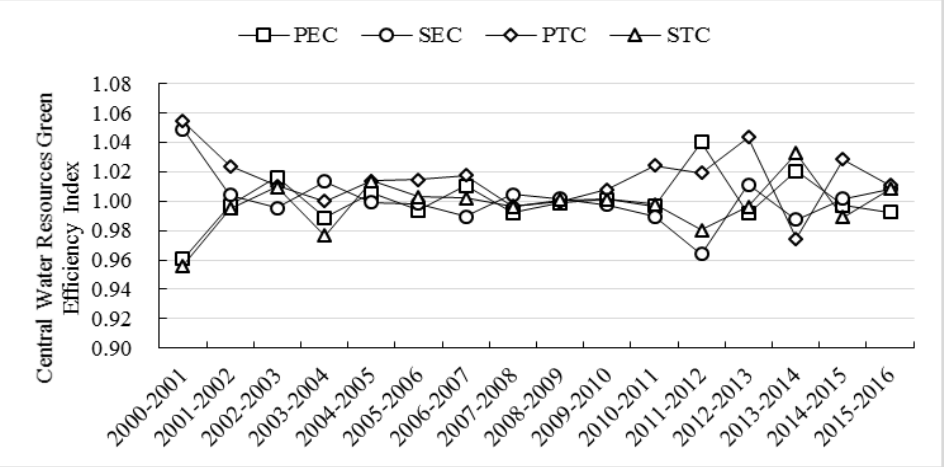
Figure 5. Changes in components of water resources green efficiency in the central region of China during the study period 2000–2016 (PEC = pure technical efficiency change, SEC = scale efficiency change, PTC = pure technology change and STC = scale technology change).